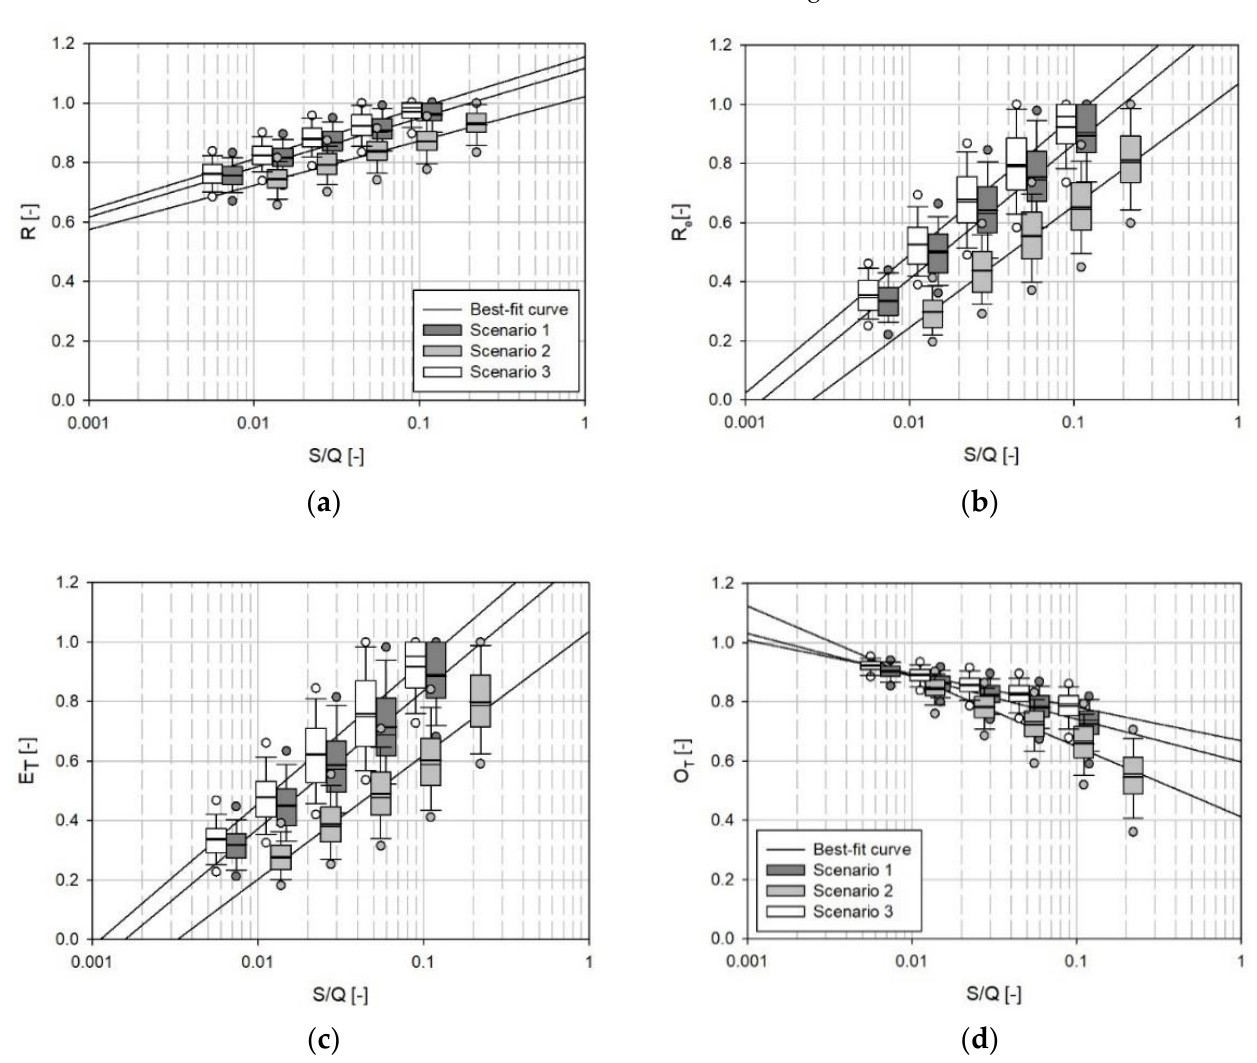
Figure 4. Box-and-whisker plots of the variability of the annual temporal reliability indices ( R and